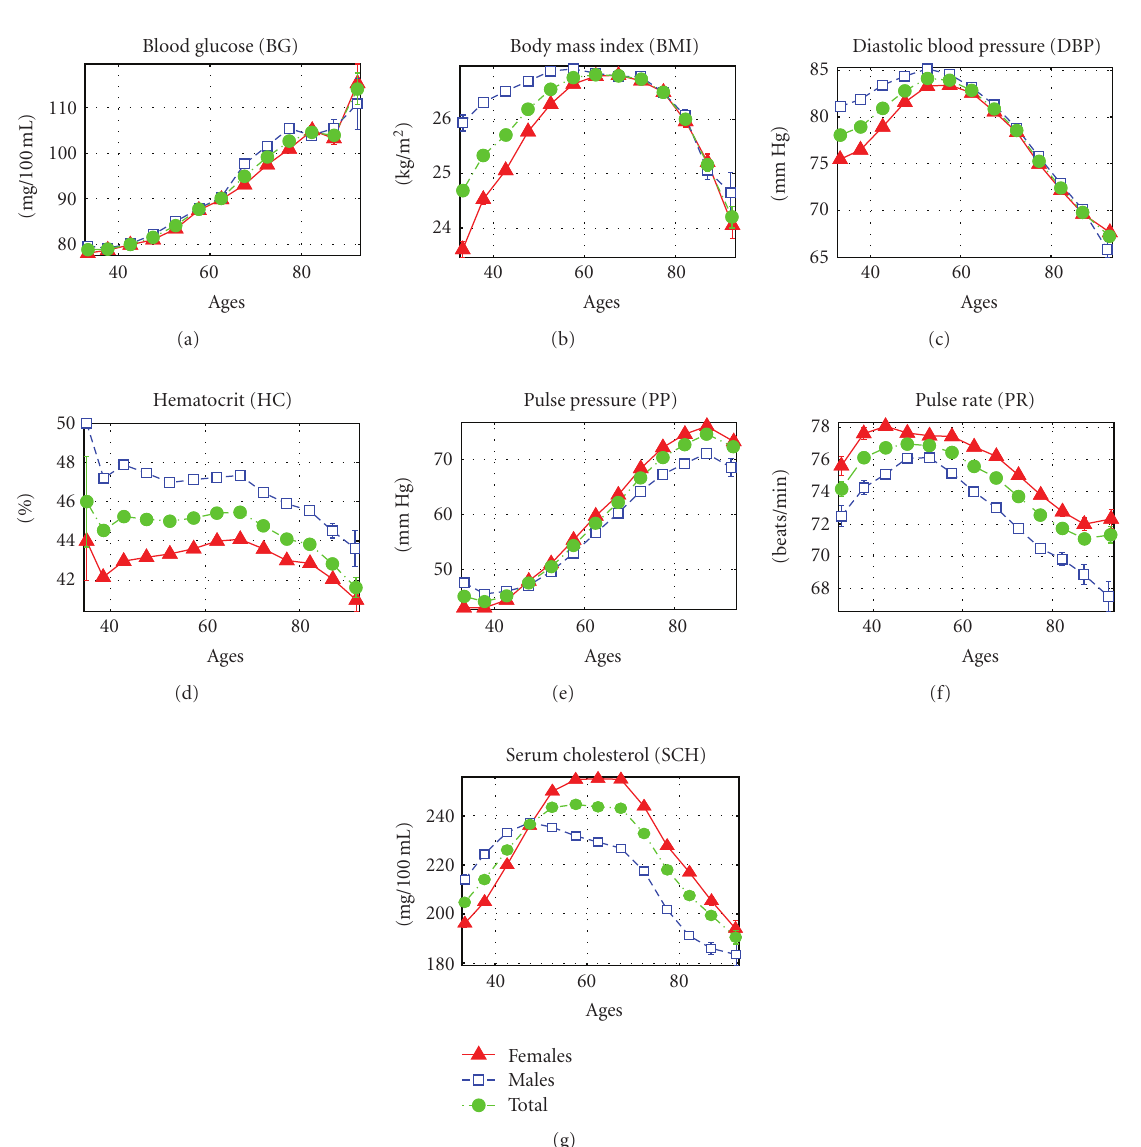
Figure 1: Mean values ( ± s.e.) of physiological indices in participants of the original cohort of the Framingham Heart Study (pooled data of available measurements from exams